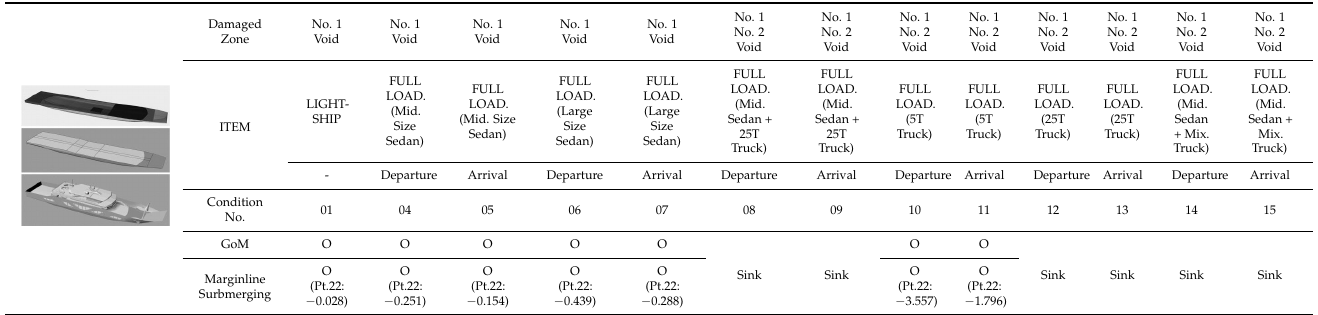
Table 4. Examples of flooding accident cases where the target ship may sink.